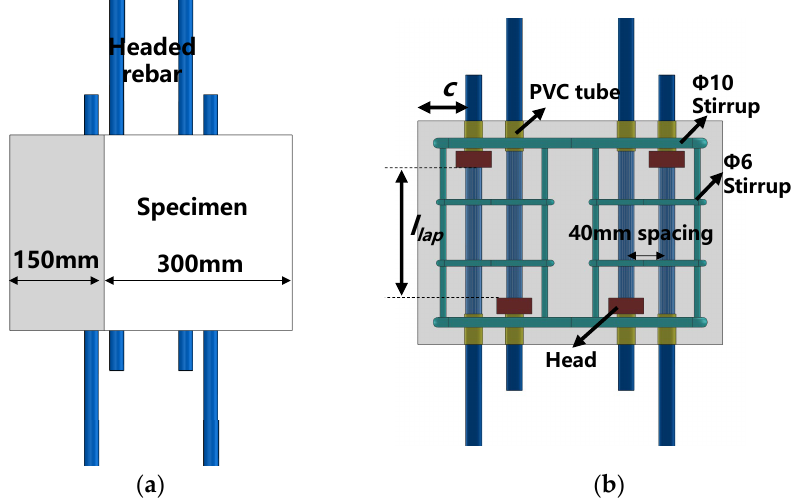
Figure 2. Sketch of the specimen ( a ) Specimen layout ( b ) Layout inside the concrete.